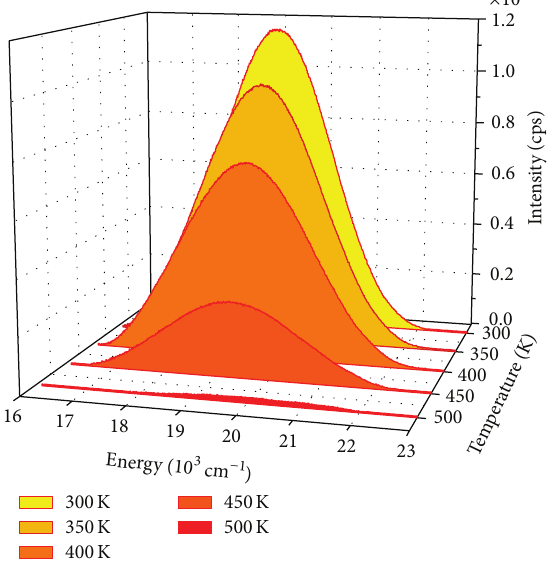
Figure 13: Effect of increased temperatures on the emission spec- = 27 620 cm −1 ) of 5 NPs. trum ( ̃𝜐 ex